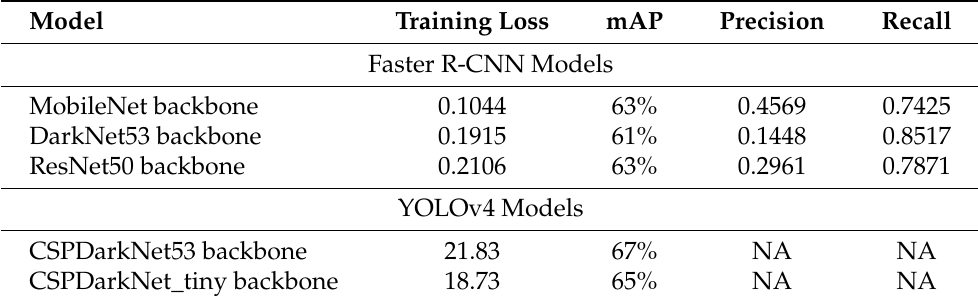
Table 4. Quantitative training results for the different variants of computer vision object detection models implemented for plastic-bag contamination